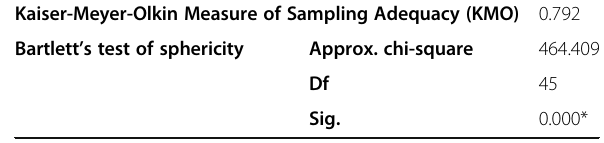
Table 9 Factor analysis by the KMO and Bartlett ’ s test